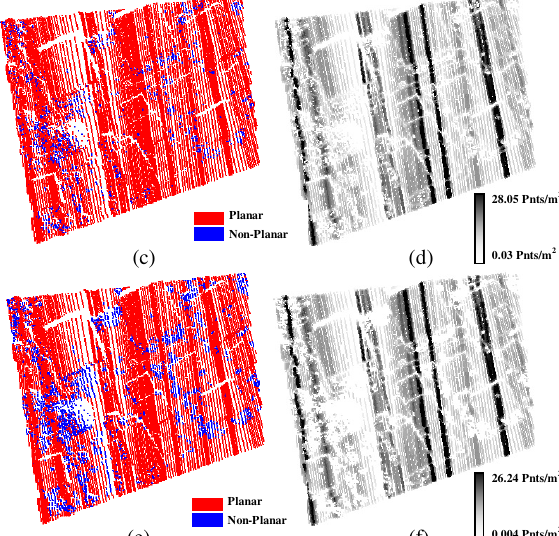
(f) Figure 7. Airborne LiDAR dataset: (a) original LiDAR data, (b) generated point density map using the approximate method, (c) planarity check result using the eigen-value analysis relative to the point in question, (d) generated point density map based on eigen-value analysis relative to the point in question, (e) planarity check result using the adaptive cylinder method, and (f) generated point density map based on adaptive cylinder method